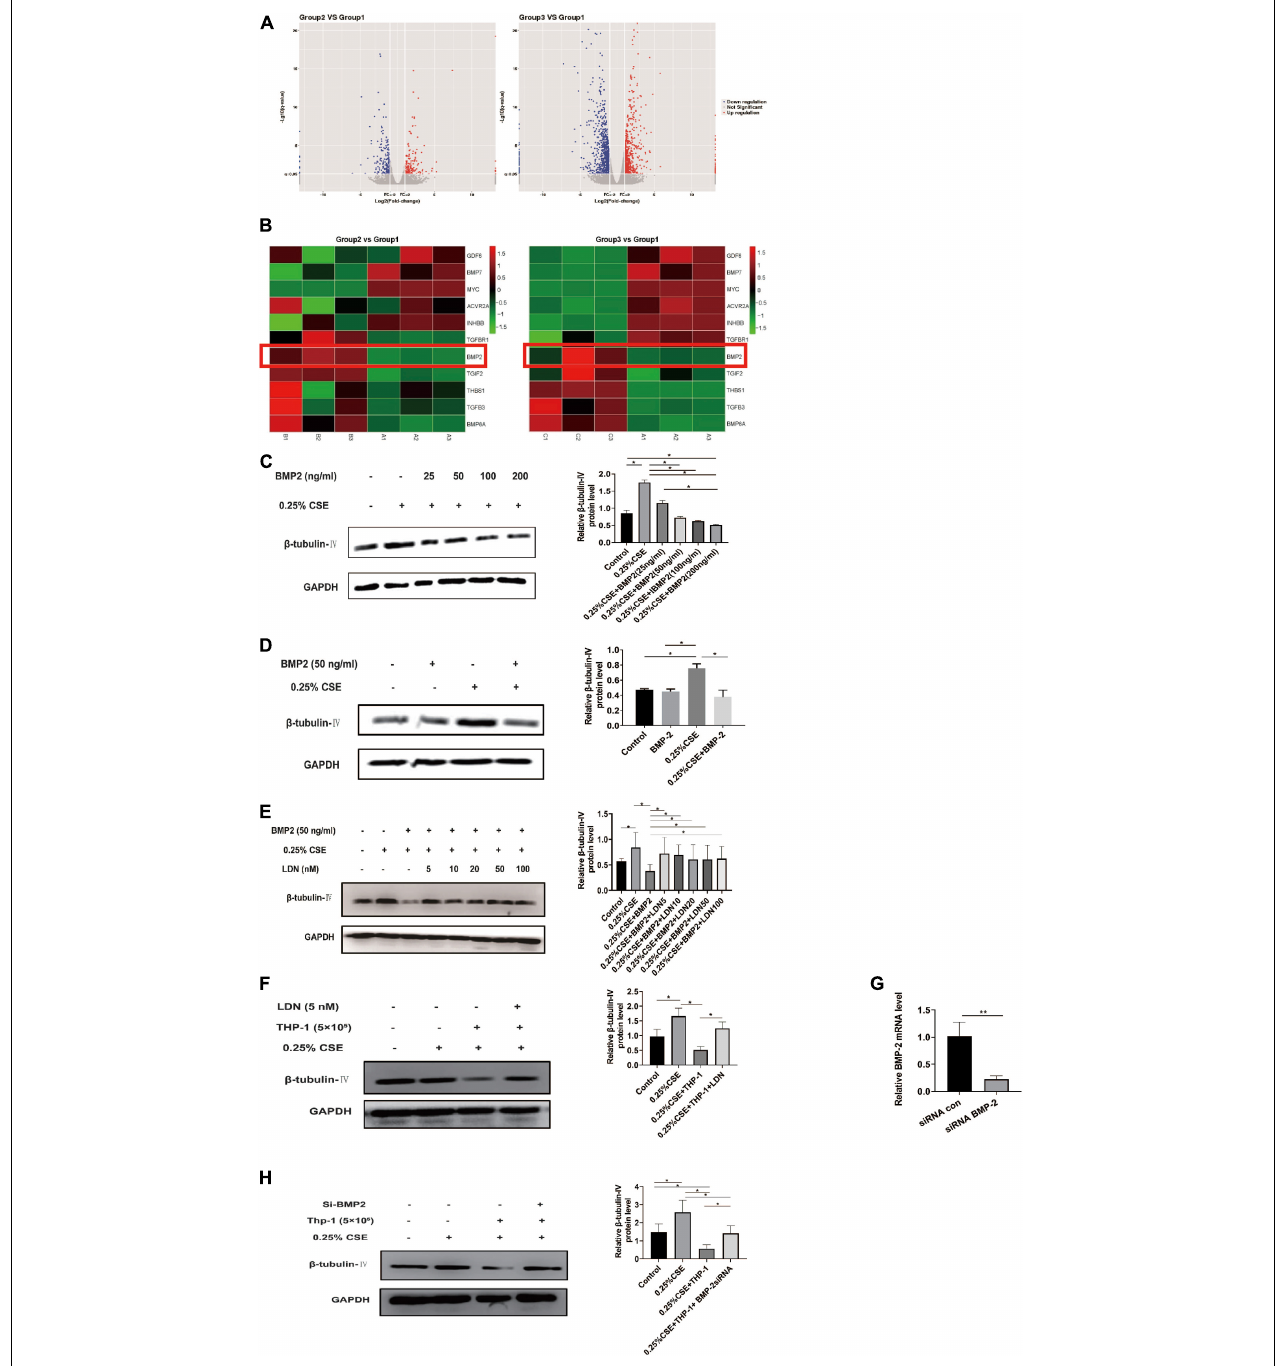
FIGURE 5 | Bone morphogenetic protein-2 (BMP-2) protein has an inhibitory effect on β -tubulin-IV levels of Beas-2B cells. (A) The volcano images of genes whose expression difference was more than two-fold in THP-1 cells co-cultured with BEAS-2B cells (group 2, B ) vs. THP-1 cells (group 1, A ) and THP-1 cells co-cultured with BEAS-2B cells under stimulation of CSE (group 3, C ) vs. THP-1 cells (group 1, A ). (B) The heat map of genes related to TGF- β superfamily in group 2 vs. group 1 and group 3 vs. group 1. (C) β -tubulin-IV levels of BEAS-2B after being stimulated with 0.25% CSE and different concentrations of recombinant human BMP-2 protein. (D) β -tubulin-IV levels of BEAS-2B after being stimulated with 0.25%CSE and 50 ng/ml recombinant human BMP-2 protein. (E) β -tubulin-IV levels of BEAS-2B pre-treated with different concentrations of BMP receptor inhibitor LDN before being stimulated with 0.25%CSE and 50 ng/ml recombinant human BMP-2 protein. (F) β -tubulin-IV levels of BEAS-2B pre-treated with 5 nM LDN before co-cultured with THP-1 cells and being stimulated with 0.25% CSE. (G) BMP2 mRNA expression of THP-1 cells pre-incubated with siBMP2 for 24 h. (H) β -tubulin-IV levels of BEAS-2B after being stimulated with 0.25% CSE and co-cultured with THP-1 cells pre-incubated with siBMP2. All β -tubulin-IV protein levels were quantitated by densitometry and normalized to GAPDH (* P < 0.05, ** P < 0.01). Red box indicates the result of BMP-2 in heatmap of RNA-seq analysis between